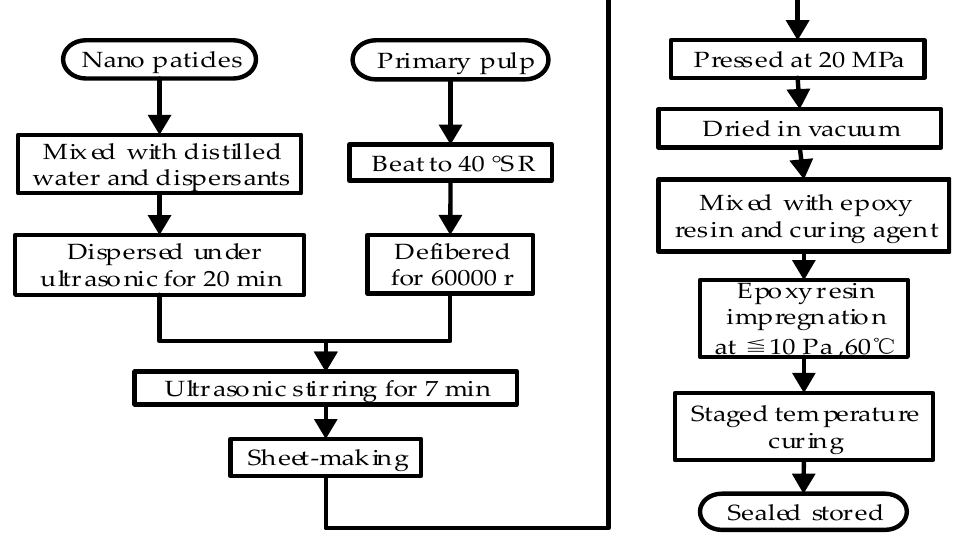
Figure 2. The flow chart of the making process of epoxy resin impregnated nano-SiO 2 modified pressboard.